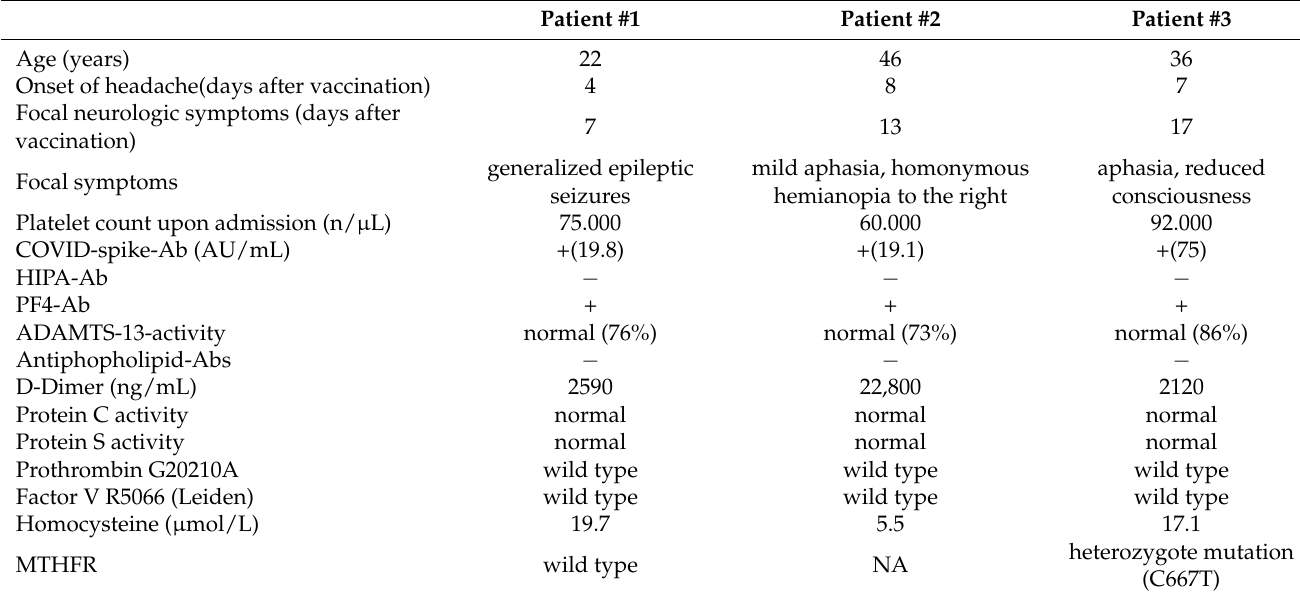
Table 1. Summarized clinical characteristics and laboratory findings in 3 patients with intracranial venous sinus thrombosis after “COVID-19 vaccine AstraZeneca”